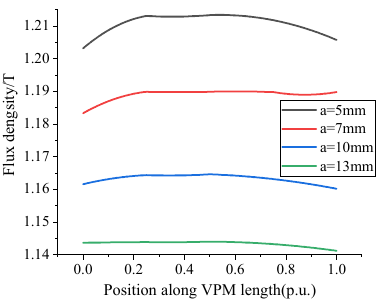
Figure 13. Low-coercive permanent magnet flux density.